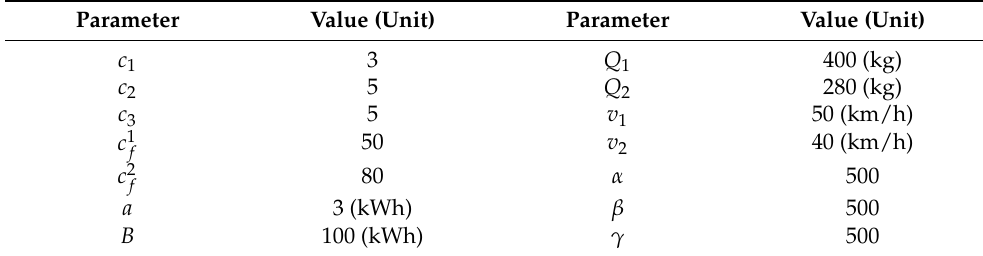
Table 2. Parameter settings for 2E-EVRPTW-BSS model.